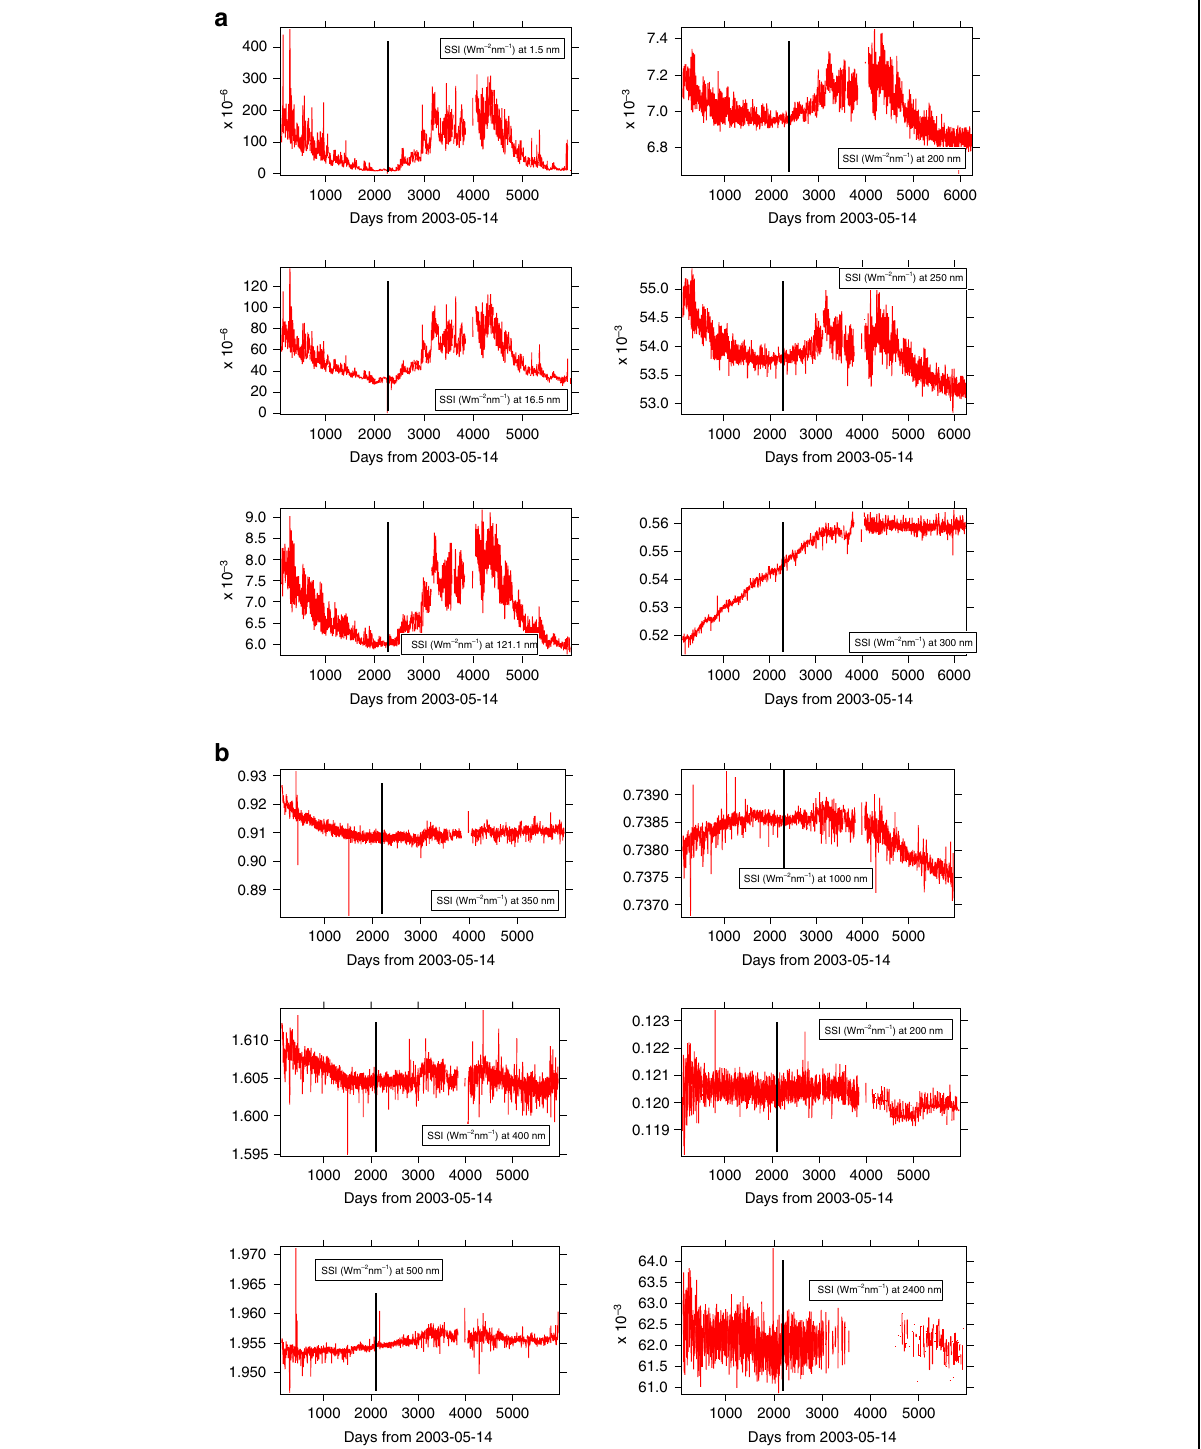
Fig. 2 Time series observed by SORCE v17 for 6 wavelengths. a 1.5 – 300 nm, b 350 – 2400 nm. The black bar indicates the 10 January 2009 for which a minimum appears in the EUV